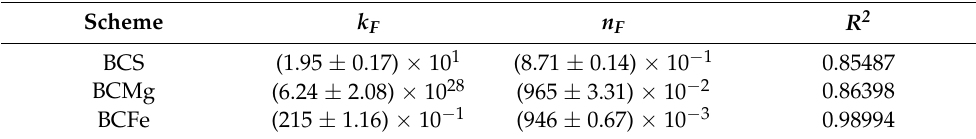
Table 8. Parameters of the Freundlich